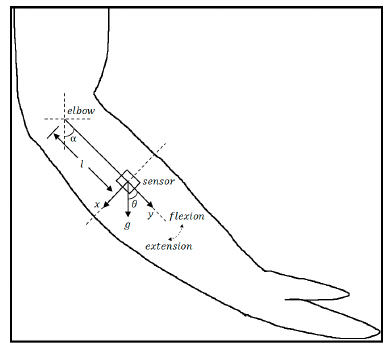
Figure 2. Location of the inertial sensor. The sensor was attached to the lateral side of the forearm. α is the elbow joint angle of flexion and extension. x and y represent the sensor’s X-axis and Y-axis respectively. l is the distance between the sensor and elbow. g represents the earth gravity. The elbow elbow join angle can be obtained by fusing the sensor’s acceleration and angular rate. join angle can be obtained by fusing the sensor’s acceleration and angular